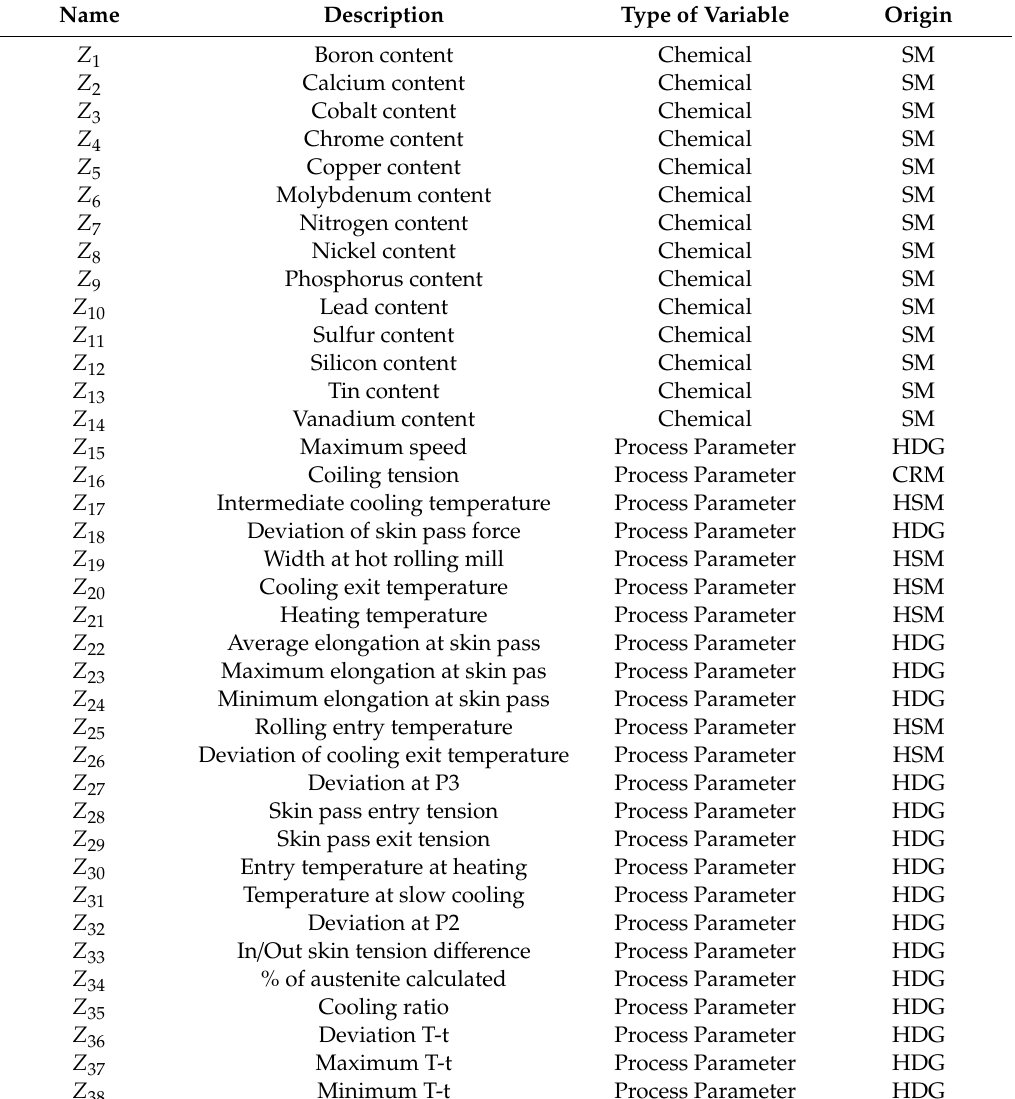
Table 1. List of variables discarded by means of the SOM